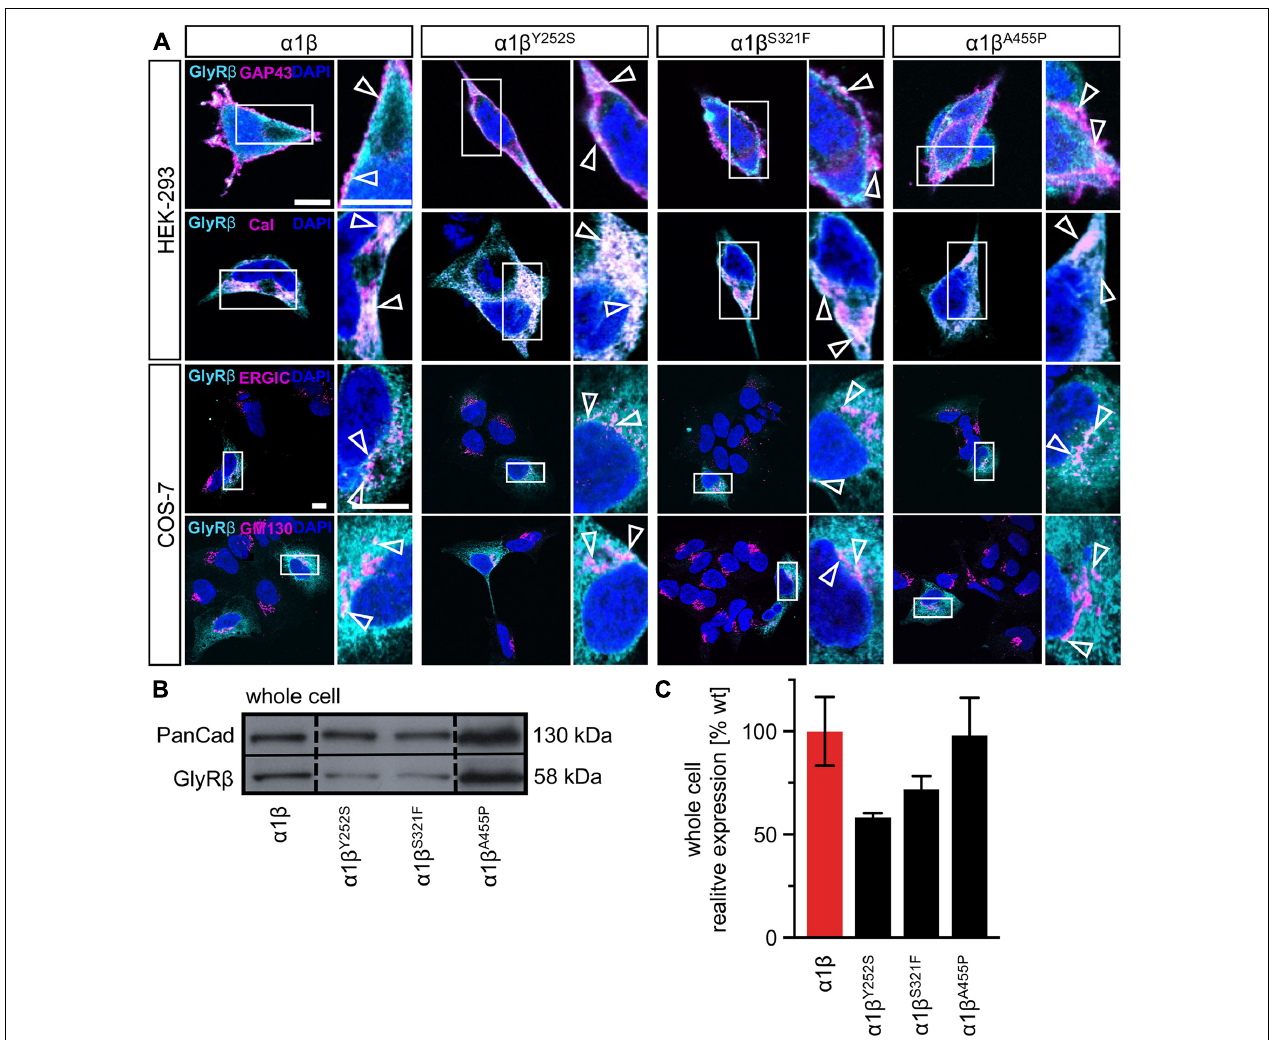
FIGURE 2 | Subcellular expression and trafficking of GlyR β mutants. (A) Immunocytochemical staining of HEK-293 (upper two lanes) or COS-7 cells (lower lanes) transfected with GlyR α 1 and β WT or β subunit variants (1:10 = α 1 WT: β WT or β x variant with x = either Y252S, S321F, or A455P). GlyR β or β x variants were stained with an anti-myc antibody (cyan), cellular compartment marker (GAP-43: cell membrane, calreticulin (Cal): endoplasmic reticulum, ERGIC: ER-Golgi intermediate compartment, GM130: Golgi) are always shown in magenta. Enlargements (marked by white box) are provided on the right next to each image, arrow heads point to co-localization or accumulation of both labeled proteins. Scale bars refer to 10 µ m. (B) Representative Western blot of whole cell protein lysates from HEK-293 cells transfected with α 1 WT and β WT or β x variants in a ratio of 1:2. GlyR β is detected at 58 kDa. Pan-cadherin (Pan-Cad) served as loading control (130 kDa). (C) Quantitative analysis of GlyR β and β x variants from whole cell lysates ( n = 3, three independent experiments) of co-expressed GlyR α 1 together with the GlyR β subunit (red bar) or GlyR β x variants (black